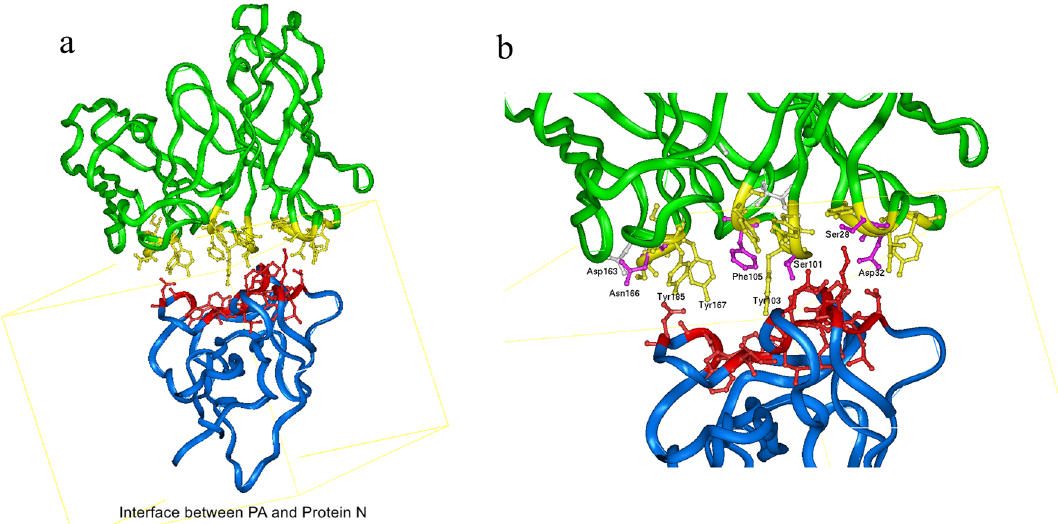
Figure 3. Analysis of important amino acid residues of 2G4 that interact with N protein. ( a ) The whole binding mode between the 2G4 scFv and N protein. The green ribbon denotes the 2G4 scFv fragment, and the blue ribbon denotes the N-terminus of the N protein. The yellow ball and stick denote the heavy atoms of the key residues in the 2G4 scFv, and red denotes the important residues in N protein. ( b ) The local binding mode between 2G4 and N protein. The red ball and stick denote the key amino acids in N protein, and the key amino acid residues are marked as name, position and heavy atom orientation.